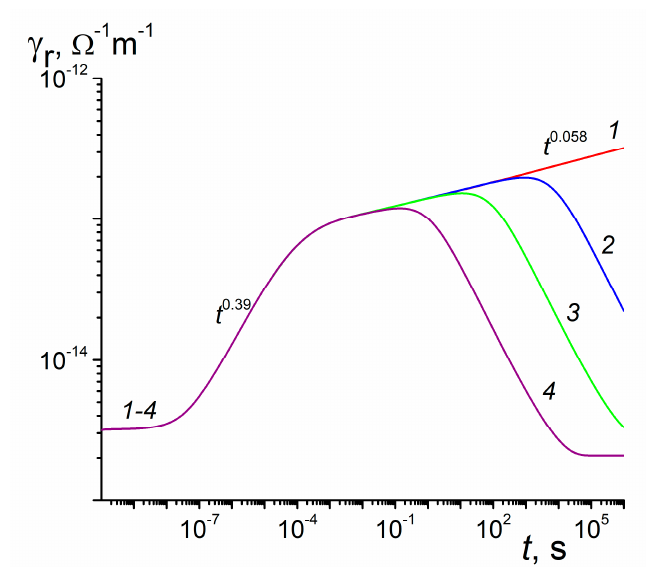
Figure 3. RIC curves calculated in a prototype polymer for the modified Rose-Fowler-Vaisberg (RFVm) model (semi-infinite geometry or alternatively, no transit time effects). Dose rate 10 14 (1) 10 18 (2) 10 20 (3) and 10 22 m − 3 ·s − 1 (4). Each curve was multiplied by a factor ξ = 10 20 (m − 3 ·s − 1 )/ g 0 (for curve (3), ξ is unity). Irradiation time 10 6 s.